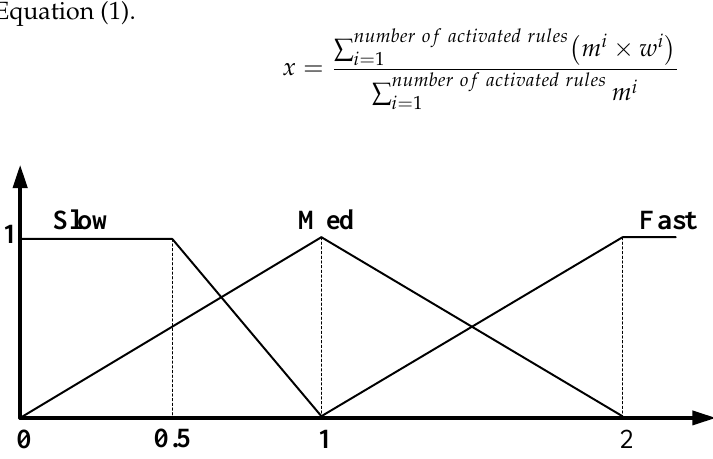
Figure 7. Output membership function.